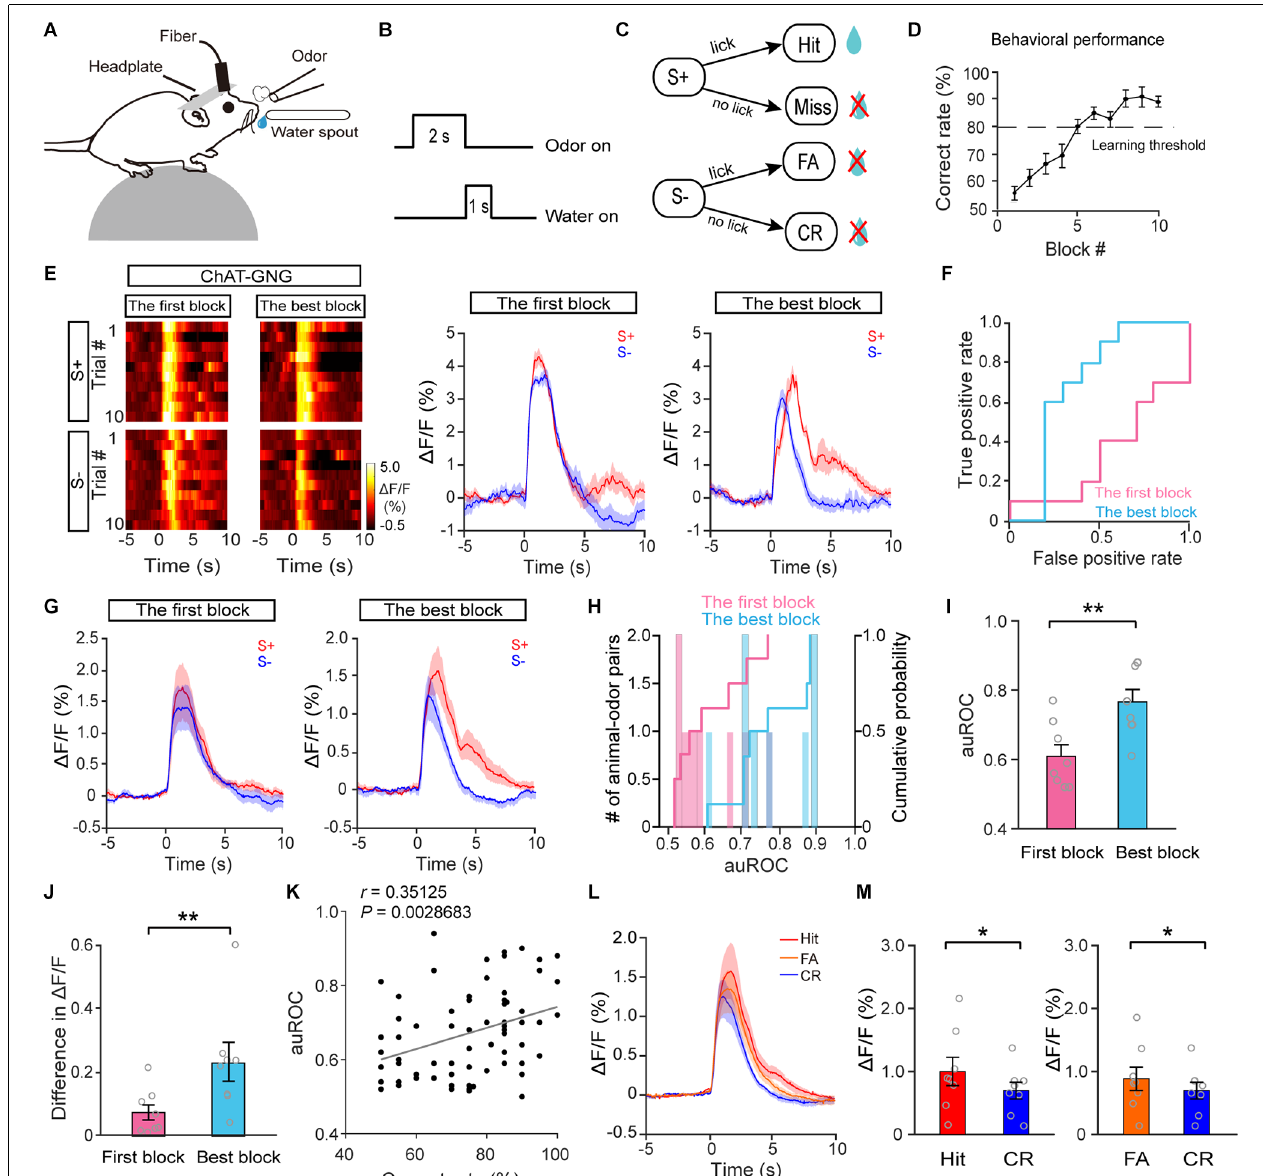
FIGURE 4 | The response profiles of HDB cholinergic neurons in S+ trials and S– trials during the go/no-go task. (A) Diagram of the experimental paradigm. (B) Timeline for a single trial in the go/no-go task. (C) Schematic of the behavioral paradigm. If an S+ was presented and the mouse responded with licking, a water reward was delivered. If an S– was presented, no water reward was delivered regardless of the mouse’s actions. (D) Odor discrimination performance during the last session in the go/no-go task. The mean percentage correct rates are plotted for each block of 20 trials. The learning threshold is indicated by a dashed line. (E) Representative heat maps and corresponding traces of cholinergic responses in S+ and S– trials in the first block and in the best block during the go/no-go task. (F) ROC graph for S+ and S–responses in the first block and the best block shown in (E) . (G) Averaged traces of cholinergic responses in S+ and S– trials in the first block and the best block across all animal–odor pairs ( n = 16 animal–odor pairs from eight mice). (H) Histograms and cumulative probability of auROCs in the first block and the best block. (I,J) Comparison of auROCs (I) and difference in ∆ F/F (J) in the first block and the best block [ (I) Paired t -test, t (7) = − 3.81, P = 0.0067; (J) paired t -test, t (7) = − 3.54, P = 0.0095]. (K) The auROCs of cholinergic responses plotted against the correct rate during the go/no-go task (Linear regression, r = 0.35, P = 0.0029, n = 70 blocks). (L,M) Comparison of averaged cholinergic responses in Hit, FA, and CR trials [ (M) Hit vs. CR, Wilcoxon signed-rank test, z = 2.52, P = 0.012, FA vs. CR, paired t -test, t (7) = − 2.54, P = 0.038]. * P < 0.05, ** P <